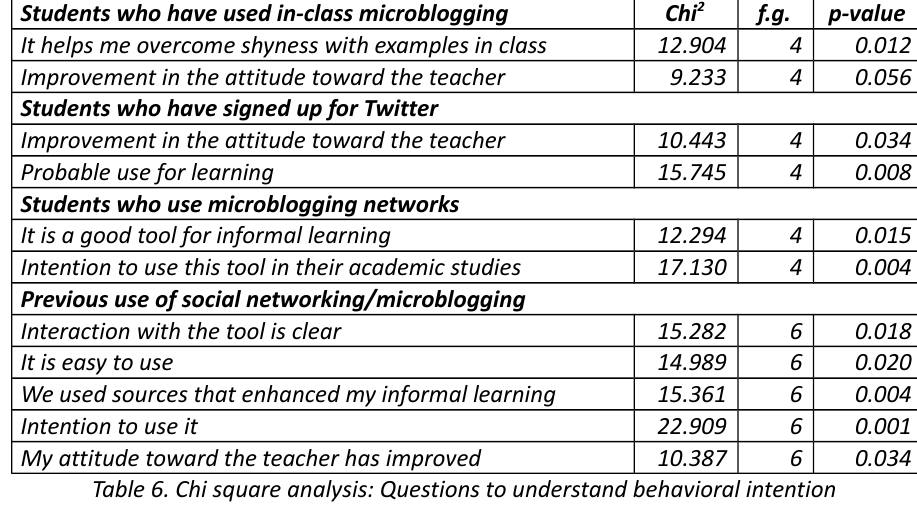
Table 6. Chi square analysis: Questions to understand behavioral intention